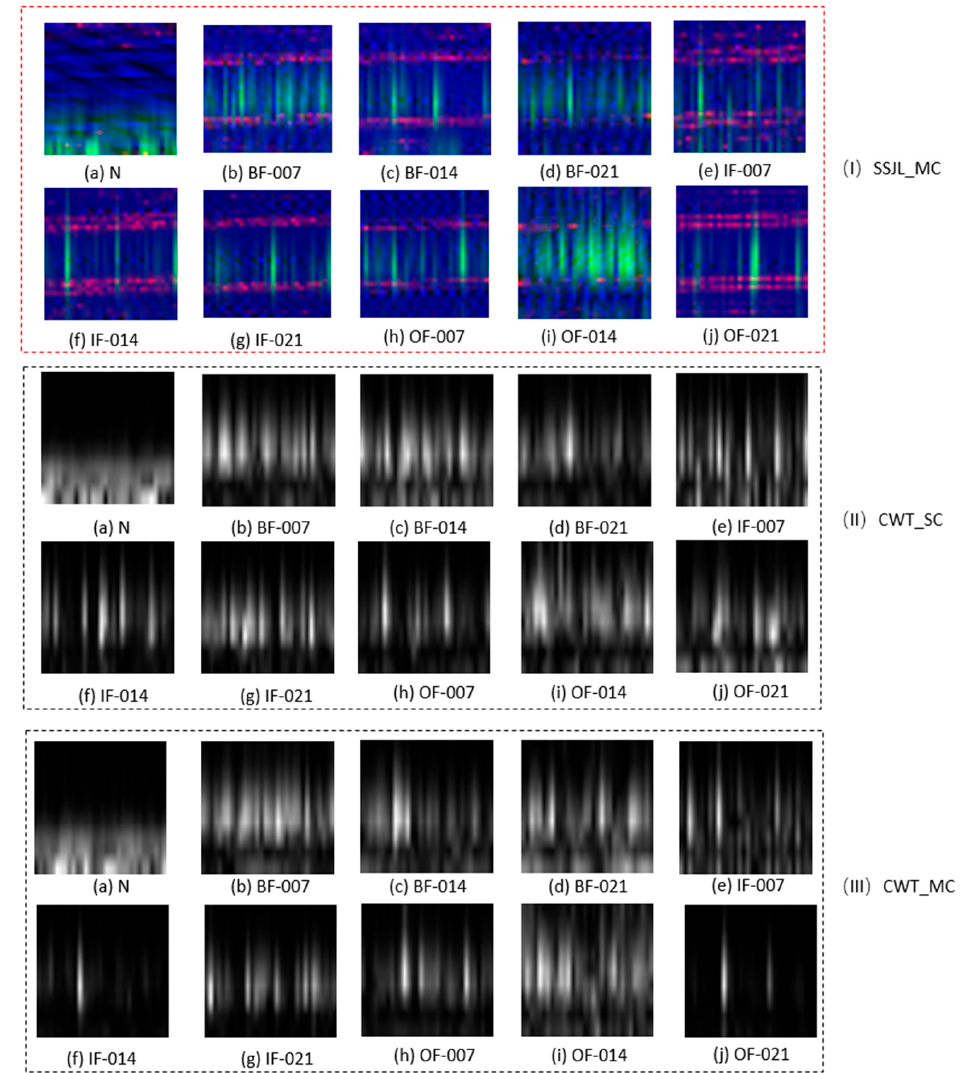
Figure 6. Vibration images obtained by different data processing methods: ( I ) SSJL_MC, ( II ) CWT_SC, and ( III ) CWT_MC.